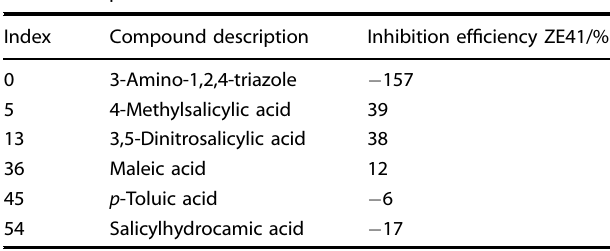
Fig. 4 Using autoencoders for outlier detection and contour maps. a Input features reduced to a two-dimensional code. b The decoder part in combination with an appropriate predictive model (such as a deep neural network) can be used to generate contour maps across the space spanned by the dimensions of the two-dimensional Table 3. Representative validation set.